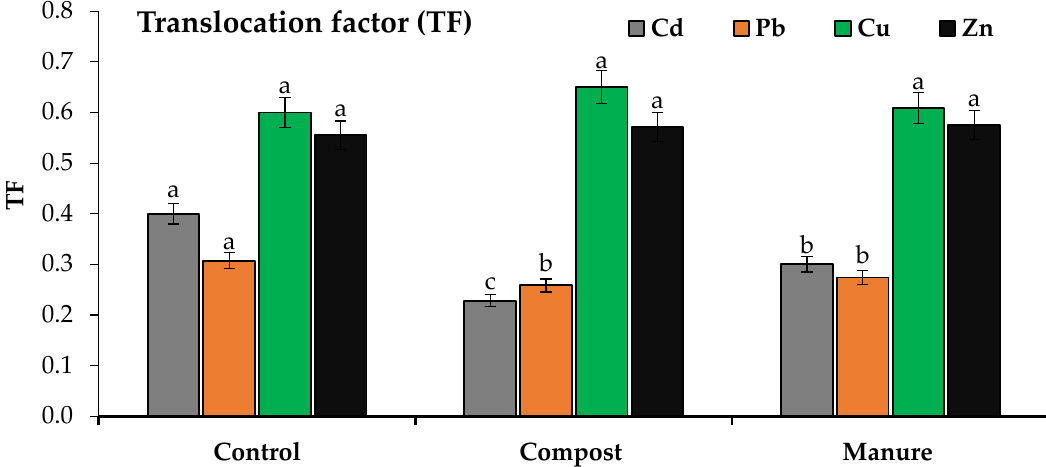
Figure 3. Effect of compost and manure on the translocation factor (TF) of heavy metals. Means (±standard deviation, n = 4) denoted by different letters are significantly different at p < 0.05.